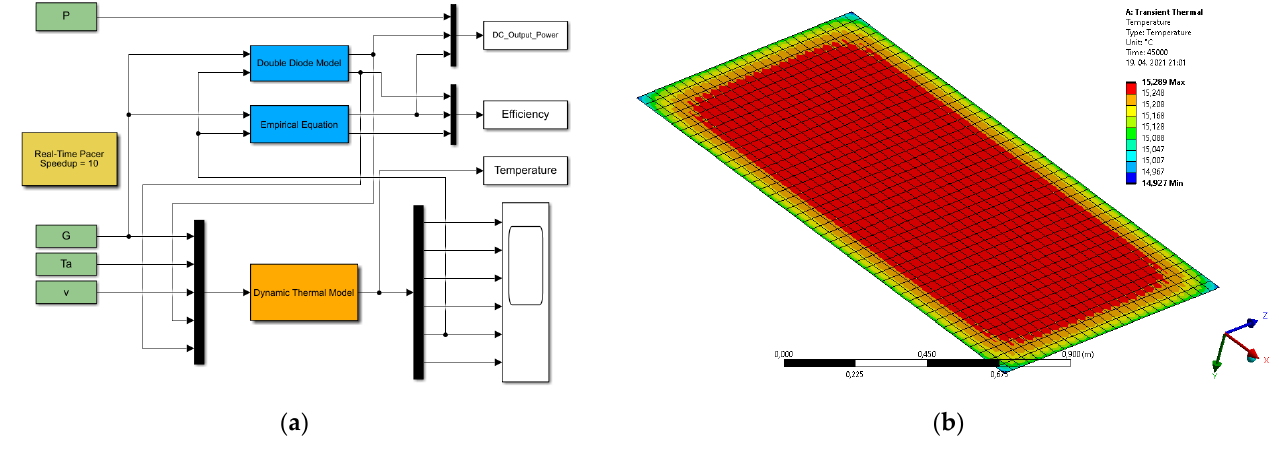
Figure 3. A thermo-electric model: ( a ) Dynamic — Matlab/Simulink; ( b ) Static — Ansys Transient Thermal. The input parameters of the dynamic-thermal model made in Matlab/Simulink were solar radiation G , ambient temperature T a , wind speed v , output power P DC and,